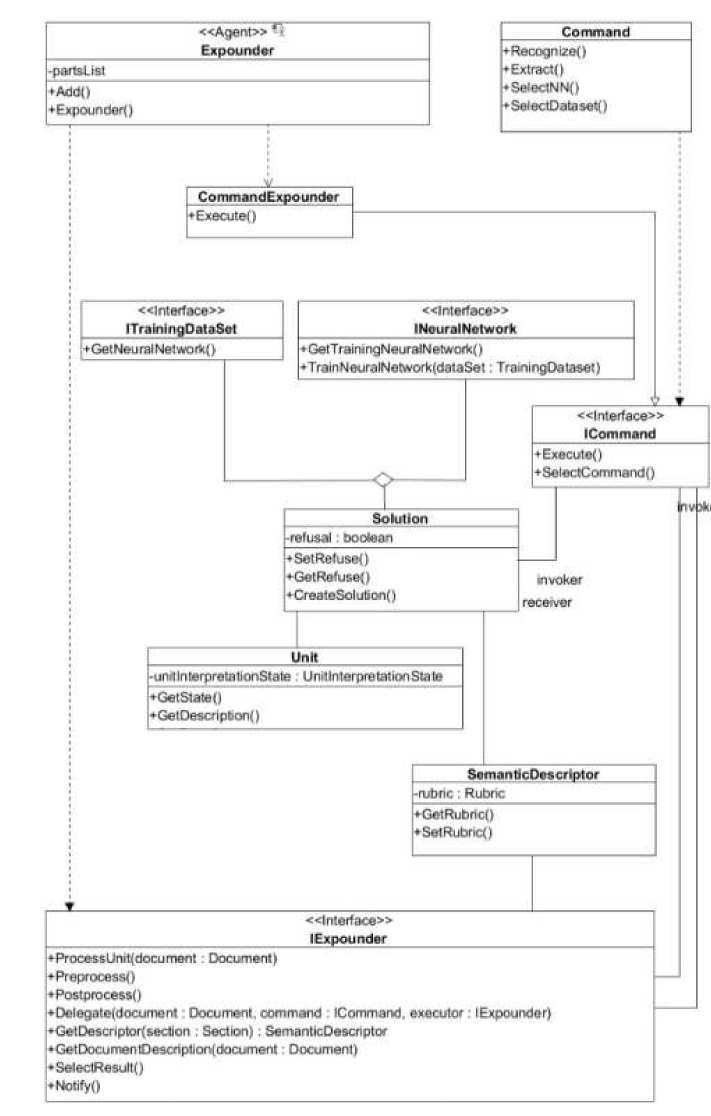
Figure 3. Expounder pattern